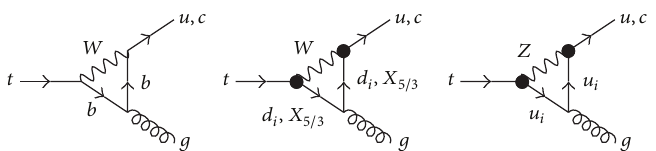
Figure 3: Feynman diagrams for FCNC top decays into 𝑔𝑞 in the SM (left) and induced at loop level by the presence of VLQs (centre and right). In the diagrams, 𝑢 𝑖 = 𝑢,𝑐,𝑡,𝑡 󸀠 and 𝑑 𝑖 = 𝑑,𝑠,𝑏,𝑏 󸀠 .